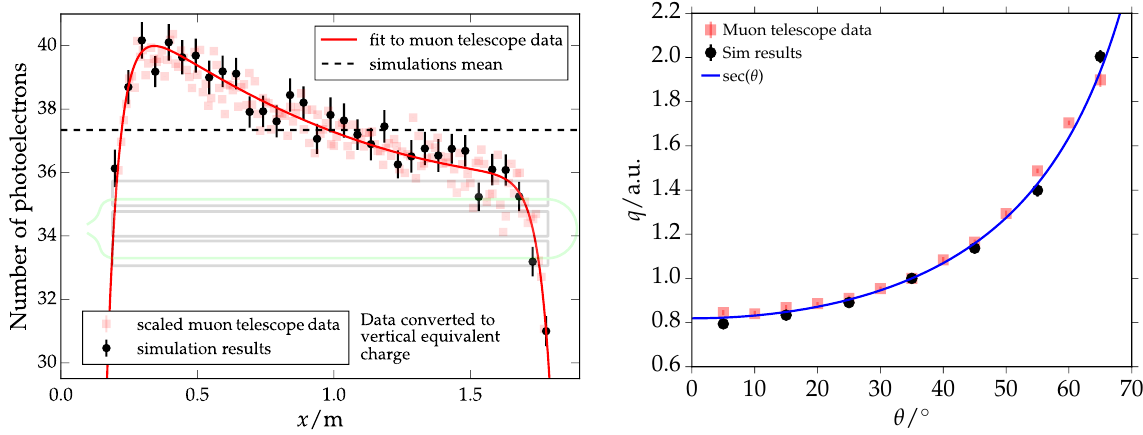
Figure 4. Left: Average charge measured for single, through-going muons as a function of the crossing position for one wing of an SSD. Measurements with the muon telescope are shown by the square, red markers, whereas simulated data is represented by the circular, black markers. Larger values on the horizontal axis correspond to crossing positions further from the central edge of the scintillator, as depicted by the semi-transparent schematic in the backdrop. Right: Average charge as a function of zenith angle. Once more, muon telescope measurements are given by the red markers, whereas simulations are shown in black. Both data sets have been scaled such that they equal one at an angle of 35 ◦ to compare their evolution with tracklength (1 / cos θ ).